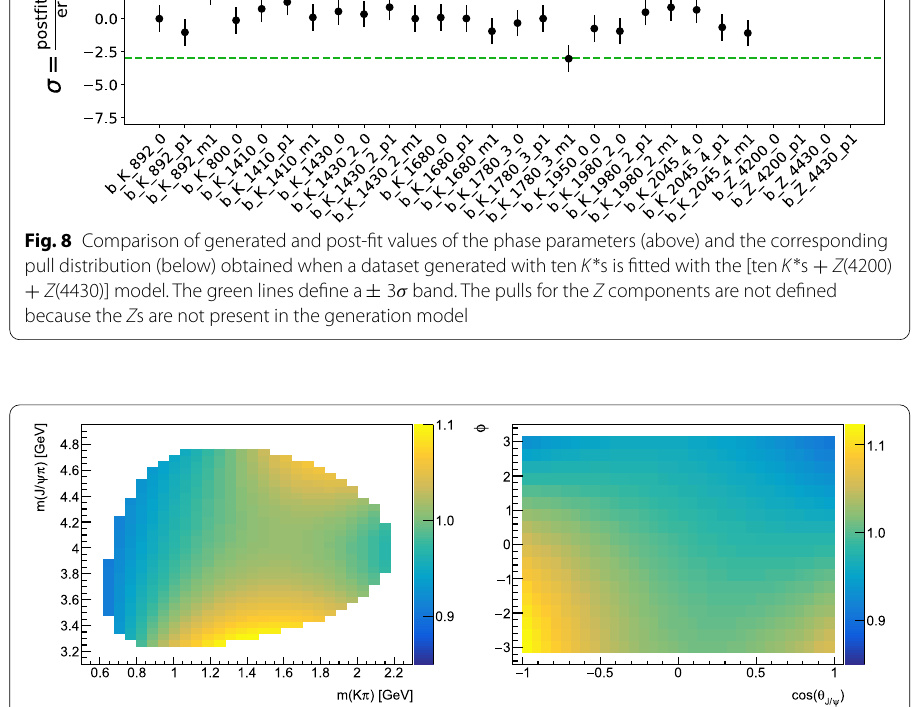
Fig. 9 Simulated template of the relative reconstruction efficiency for the scatter plots of the two mass variables (left) and the two angular variables (right) of the decay. In the former, the 2D kinematic boundary reflects the decay